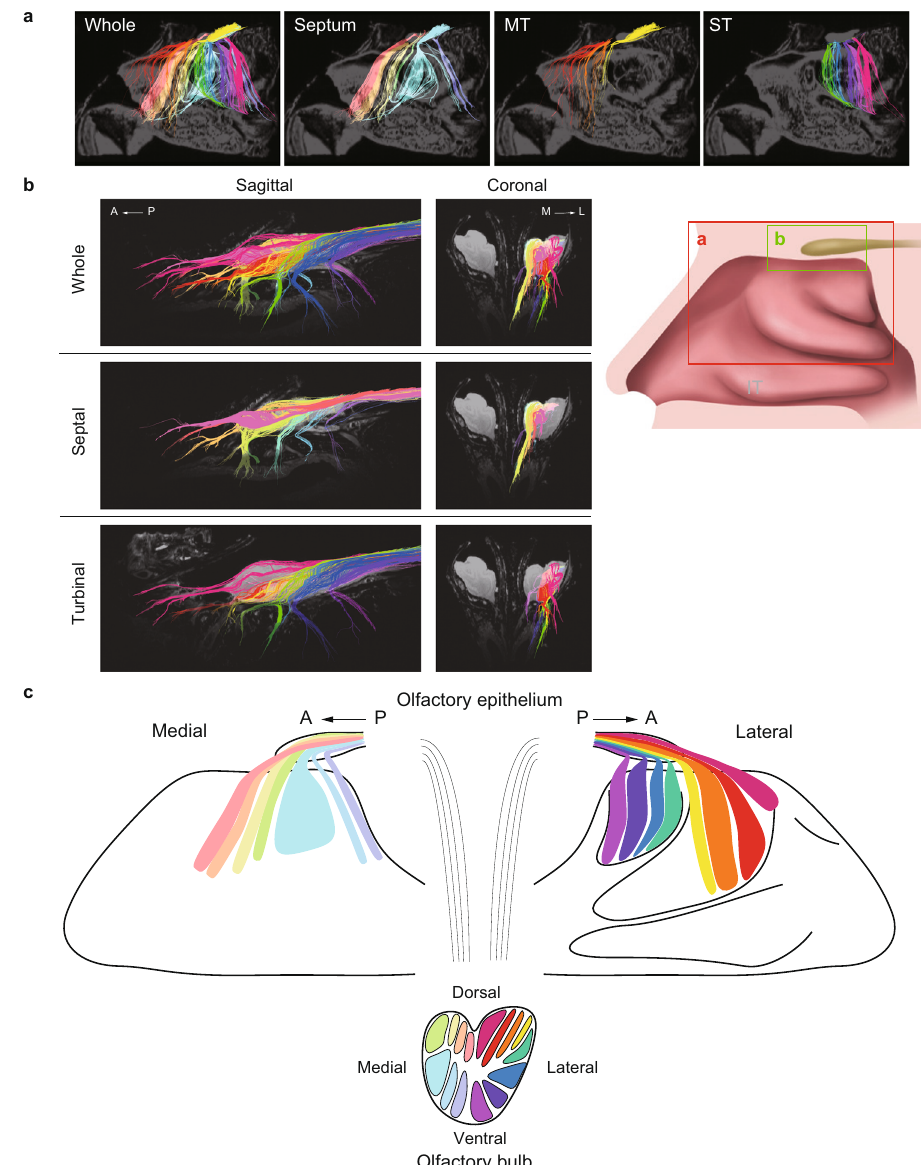
Fig. 8 The topographical relationships of the human olfactory nerves running between the olfactory epithelium and olfactory bulb. a Sagittal sections depicting the nerve pathways from the olfactory epithelium to the olfactory bulb. The fi bers are colored separately according to each olfactory fi lament. The fi eld-of-view was limited to the red frame shown in the schema due to the restricted size of the magnetic resonance imaging system. The Whole image is a combination of the other three images. MT middle turbinate, ST superior turbinate. b Tractography performed with a cryoprobe. The fi eld-of-view was limited to the green frame shown in the schema. The fi bers are colored separately according to each olfactory fi lament. c Schematic diagram showing the DTT-based olfactory nerve map for the human (the distribution of the olfactory nerves running between the olfactory epithelium and olfactory bulb). Topographically, there was a correlation between the distributions in the olfactory epithelium and olfactory bulb in both the dorsal-ventral and medial- lateral axes. A anterior, P